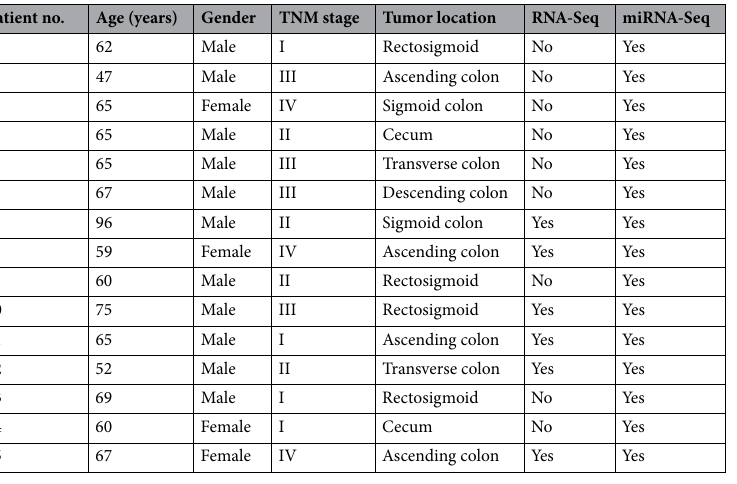
Table 1. Characteristic features of study populations. All patients presented with moderately differentiated tumors. CRC colorectal